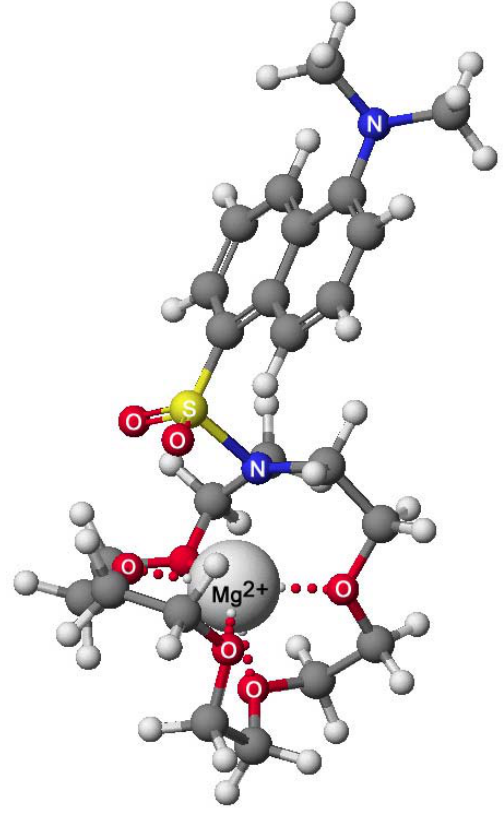
Fig. 7 The optimalized structure of (A18C6-Dns + Mg) 2+ complex.